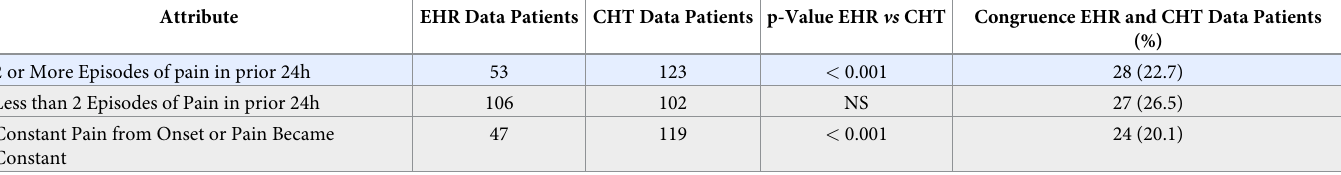
frequency of pain was missing in one patient with epigastric and right posterior chest pain at the level of T7-12. The CHT program excluded acute coronary syndrome from the working differential for this patient. EHR data was missing for 95 of 119 patients with CHT findings of constant pain since onset or pain that became constant. Time domain data was missing in EHRs for 22 patients reporting constant pain for 12–24 hrs during CHT and for 49 patients reporting constant pain for > 24 hrs during CHT.